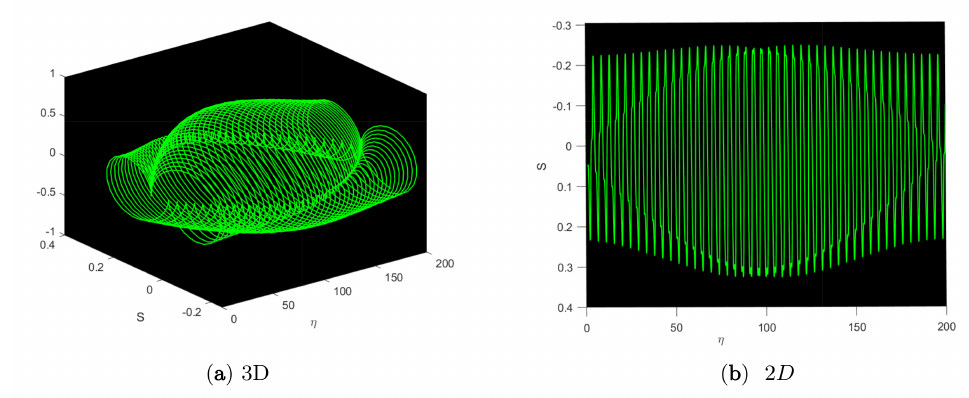
Figure 15. Phase portrait with perturbation term having a 1 = − 2, a 2 = − 2, a 3 = 2, n 0 = 0.94, and f = 4.2 for the dynamical system.